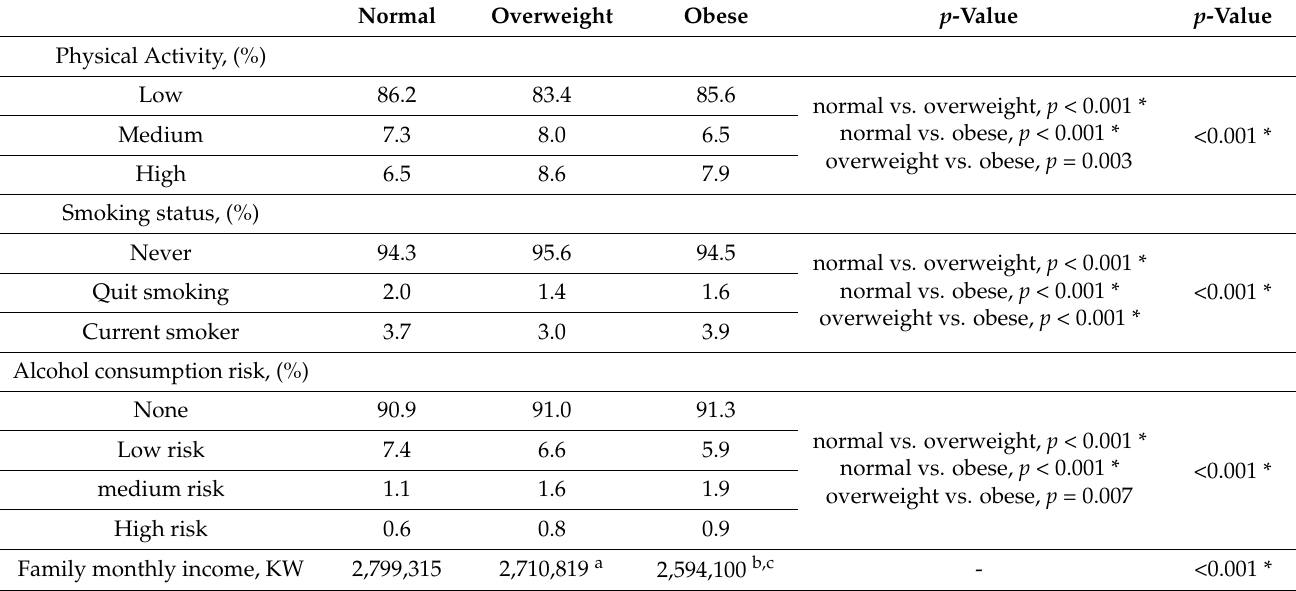
Table 3. Incidence of cerebrovascular diseases and adjusted relative risk based on BMI and physical activity classifications. Model 1 Model 2 Model 3 P.A Incidence (%) ARR (95% CI) p ARR (95% CI) p ARR (95% CI) p Low 5.7 Normal Medium 5.4 BMI 18.5–24.9 Low 9.4 Overweight Medium 8.6 BMI 25.0–29.9 Obese BMI ≥